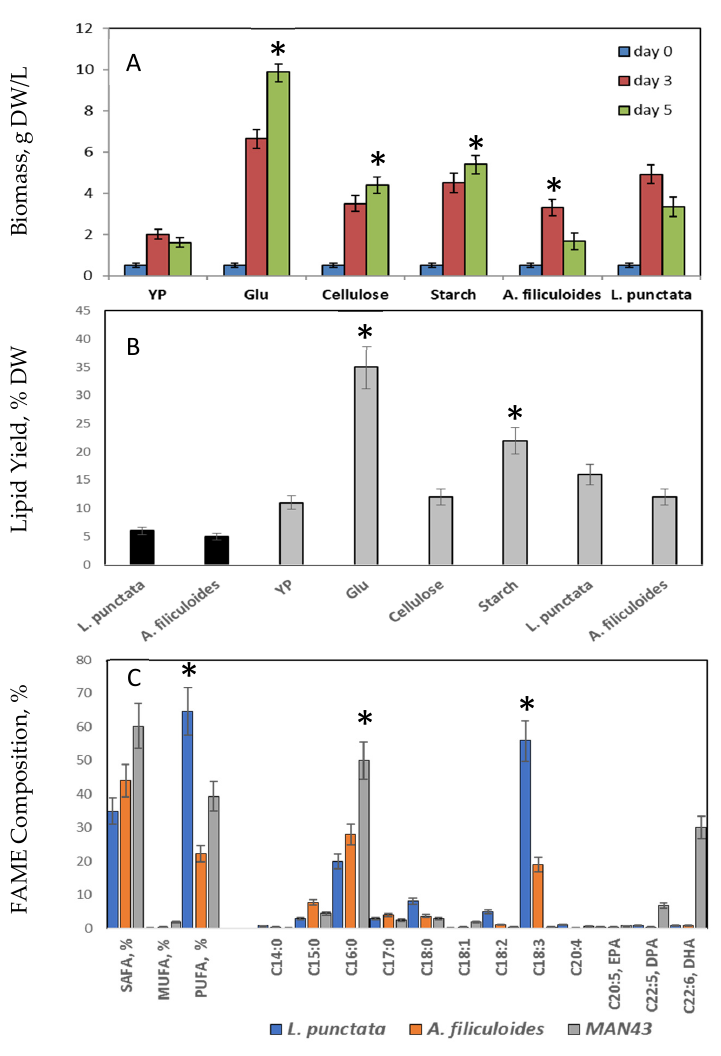
Figure 3. (A): Growth of MAN43 cells in YP media supplemented with different carbon sources. Glu: glucose; (B): Lipid yields in L. punctata, A. filiculoides and MAN43 cells grown on different carbon sources. Black boxes: total lipids extracted from L. punctata and A. filiculoides; grey boxes: lipid yields in MAN43 cells grown on different carbon sources. Glu: glucose; Gly: glycerol. (C): FAME composition of lipids extracted from L. punctata, A. filiculoides and MAN43 grown on glucose. * Significance levels: p < 0.05. Unicellular, heterotrophic marine protists, thraustochytrids, have been extensively studied over the last decade because of their biotechnological applications in human health and biodiesel production [89–93]. They are rich in lipids (up to 50% DW) and are known for their ability to grow on dead mangrove leaves secreting cellulose- and starch-degrading enzymes [94–96]. A new thraustochytrid strain, MAN43, isolated from mangrove sediments was assessed in this study for its growth and lipid production using on L. punctata and A. filiculoides biomass as a carbon source (Figure 3 and Figure S5).